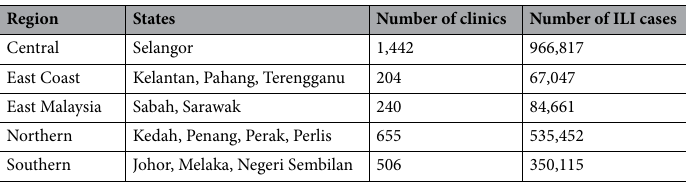
Table 2. Definition of the Five Regions in Malaysia 18 .